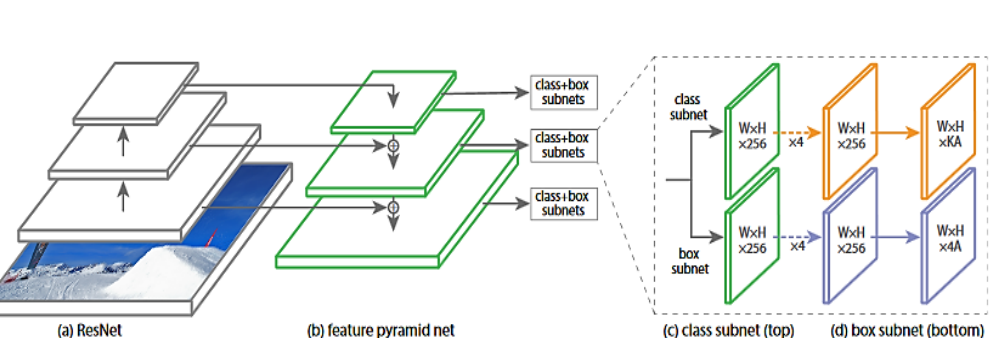
Fig. 3. RetinaNet